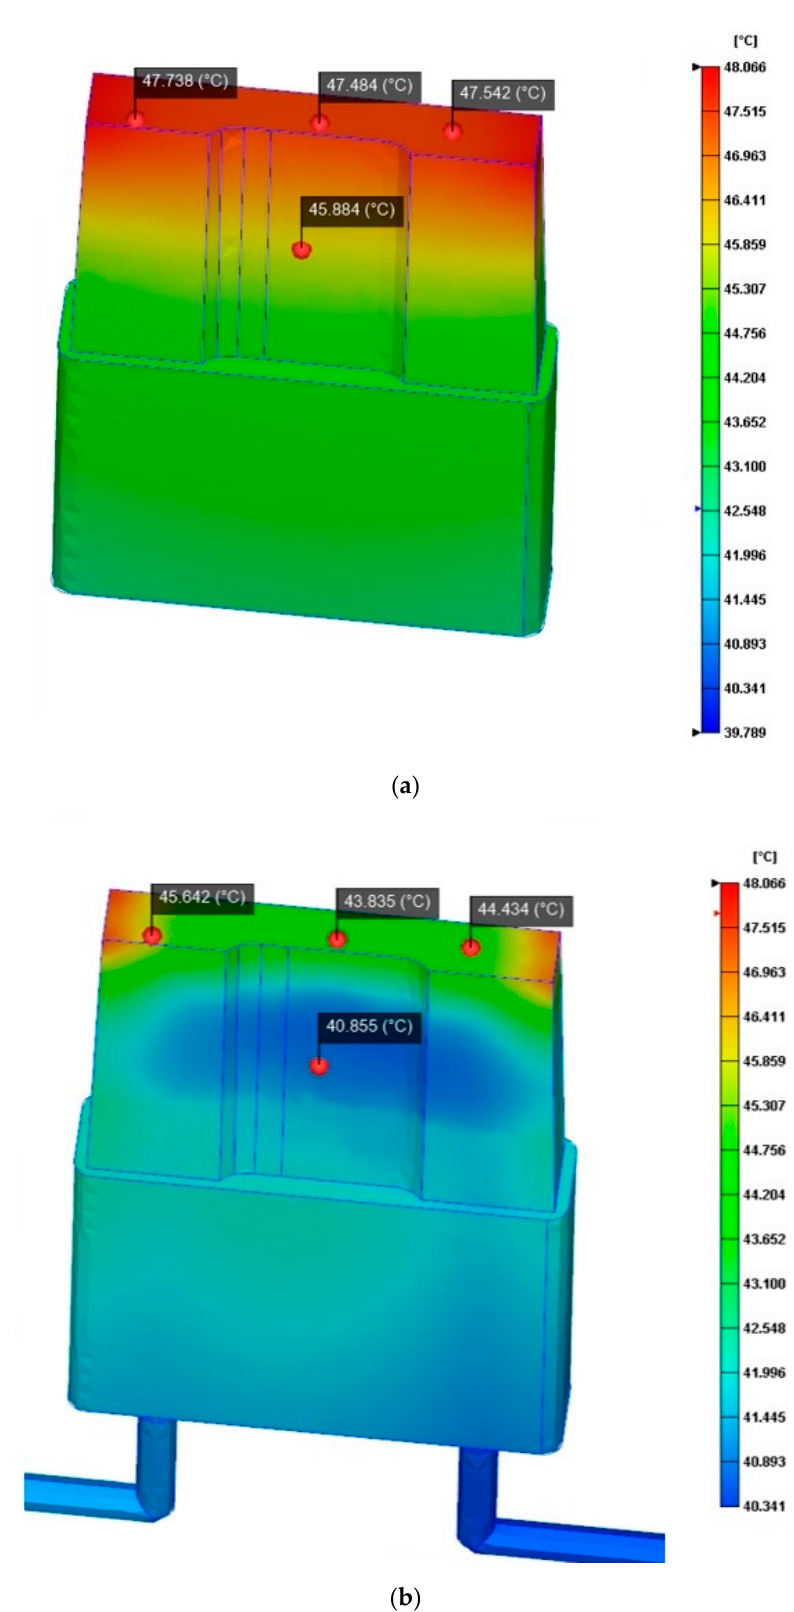
Figure 8. Results of the insert temperature distribution numerical analysis obtained at time = 59 s with Moldex3d. ( a ) Temperature distribution of the original insert (without conformal cooling). ( b ) Temperature distribution of the redesign of the insert (with conformal cooling channels).